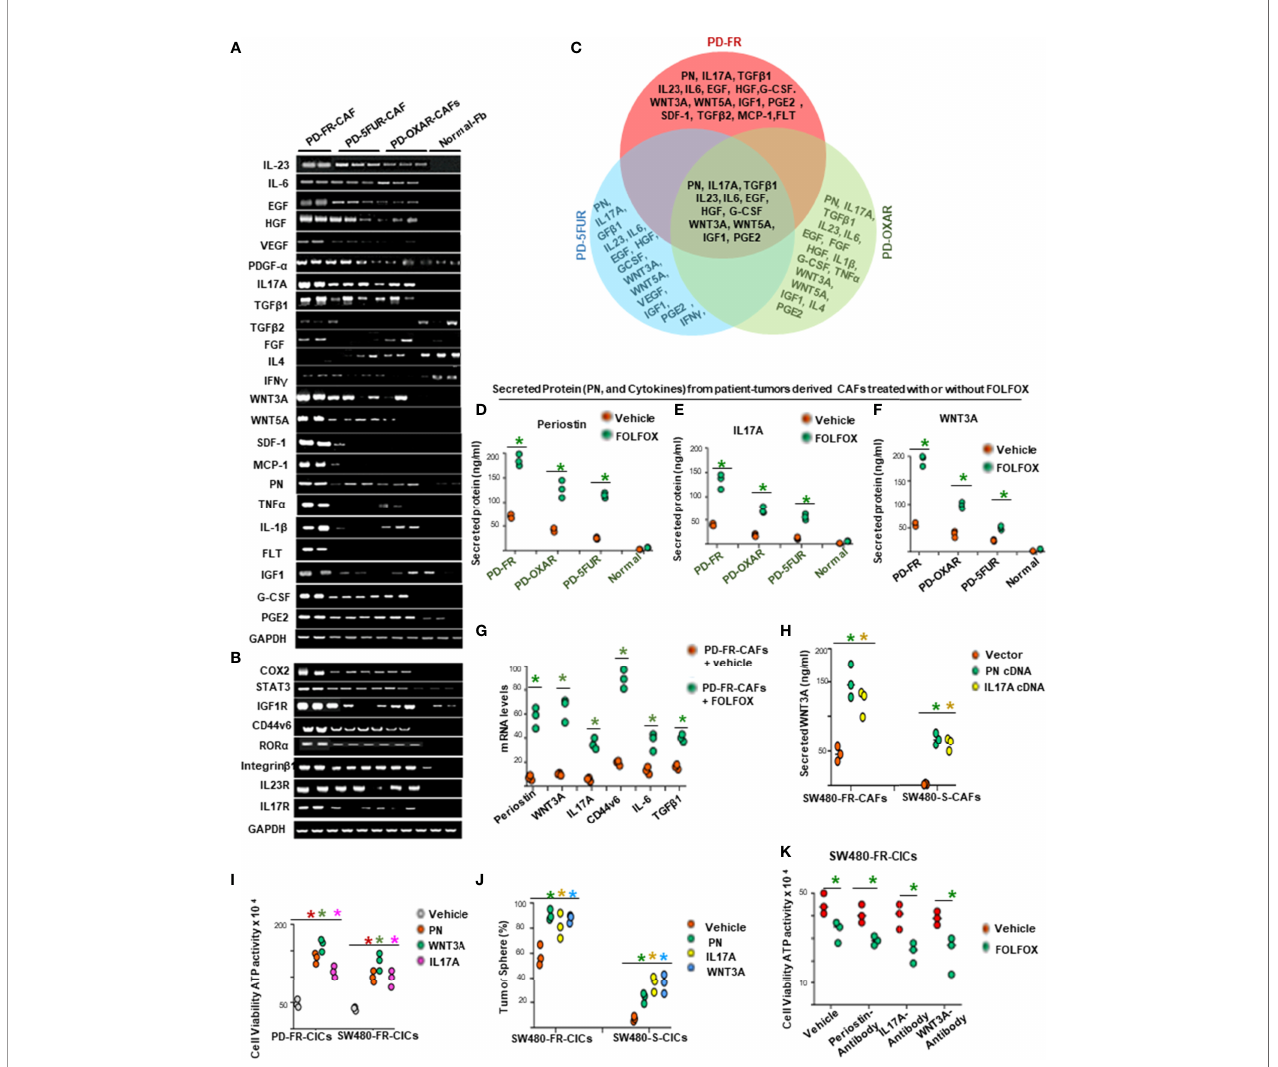
FIGURE 4 | FOLFOX induces cytokine secretion in CAFs. (A, B) , Basal mRNA expression levels of PN and the indicated growth factors, and of growth promoting cytokines and related molecules (A, B) , were analyzed by semi quantitative RT-PCR in eight indicated CAFs isolated from drug resistant patient tissues and from three normal fi broblasts (Fb). GAPDH was the reference gene. (C) , Venn diagram shows common cytokines isolated from PD-5FUR, PD-OXAR and PD-FR from the experiment in (A) . (D – F) , CAFs derived from three patient colorectal tumor (PD)-tissues and one normal intestinal fi broblast cell line were analyzed for their PN and two dominant cytokines (IL17A and WNT3A) after FOLFOX treatment. (G) , QPCR analyses are shown of PN and 4 major cytokines (WNT3A, IL17A, IL6 and TGF b 1) and of CD44v6 in patient tumor CAFs treated with DMSO or FOLFOX for 72 hours. GAPDH was the reference gene. (H) , PN and IL17A stimulated WNT3A production in CAFs isolated from sensitive and FR tumors of SW480 were assessed by transfecting these freshly isolated CAFs by vector control, PN and IL17A expression plasmids for 72 hours. Secretion of WNT3A was measured by an ELISA assay. (I) , Effects of PN, IL17A and WNT3A on cell viability were assessed by using ATP Glo assay on PD-FR CICs and SW480-FR CICs. The effects were assessed in these different specimens by culturing 104 CICs with vehicle, or with 20 ng/ml of PN, IL17A or WNT 3A for 12 hours. (J) Percentages of colon tumor sphere formation are shown in tumor spheres isolated fromCICs of FR-resistant and sensitive cells of SW480 in the absence and presence of 50 ng/ml of either PN, or IL17A or WNT3A proteins. (K) , Effects of the autocrine PN, IL17A and WNT3A production in growth of tumor spheres-derived CICs (CICs) were examined by studying the effects of blockade of PN, or IL17A or WNT3A on the tumor-initiating capacity of 1 x 104 CICs. The effects were evaluated in CICs by 12-day cultures with vehicle or FOLFOX alone. Cell viabilities (# of viable cells) were measured by ATP Glo assay. Data are presented as Mean ± SD from n = 3 – 5 independent replicates in three independent experiments. All semi quantitative RT-PCR data are representative of three experiments. (D – F) , *P < 0.05 was considered signi fi cant, Secreted protein of FOLFOX treated groups compared to vehicle control group. (G), *P < 0.05, was considered signi fi cant, FOLFOX treated groups compared to vehicle control group. (G) *P < 0.05 was considered signi fi cant, the mRNA levels of FOLFOX treated CAFs were compared with vehicle treated CAFs. (H) , *P < 0.05 was considered signi fi cant, secreted WNT3A in PN, and IL17A overexpressed CAFs compared with vector control. (I) , *P < 0.01 was considered signi fi cant, percent cell viability stimulation with PN, WNT3A, and IL17A treatment compared with vehicle-treated cells after normalization to growth of untreated controls. (J) , *P < 0.05 was considered signi fi cant, percent tumor sphere stimulation with PN, WNT3A, and IL17A treatment compared with vehicle-treated CICs from S-CICs, and FR-CICs of SW480 cells after normalization to untreated controls. (K) , *P < 0.01 was considered signi fi cant, percent cell viability stimulation with FOLFOX treatment group compared with vehicle-treated CICs that were pre-treated with PN-, or IL17A-, and WNT3A-antibodies. Student ’ s t-test was used to assess the signi fi